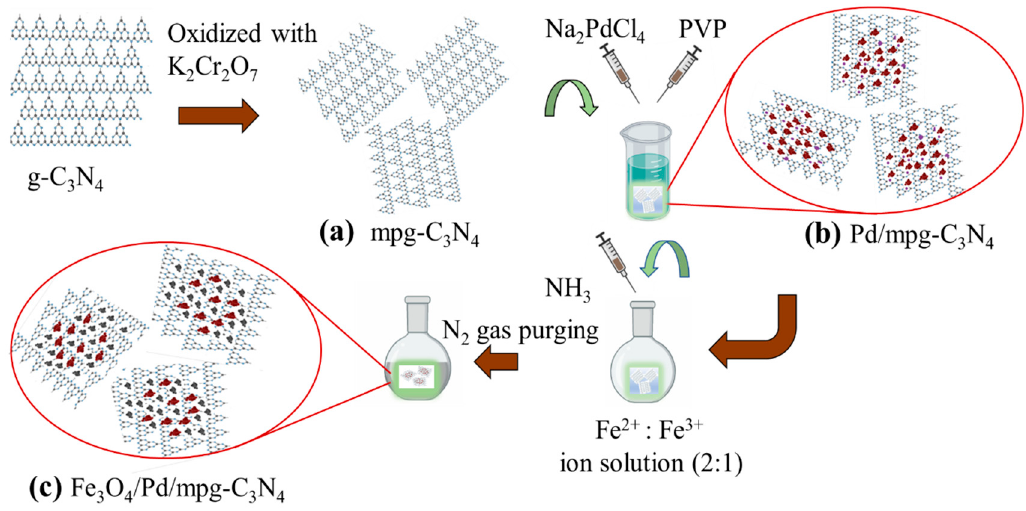
Figure 8. Stepwise synthesis process of Fe 3 O 4 / Pd / mpg-C 3 N 4 nanocomposites: ( a ) mpg-C 3 N 4 nanosheets, ( b ) Pd-decorated mpg-C 3 N 4 nanosheets, ( c ) Fe 3 O 4 / Pd / mpg-C 3 N 4